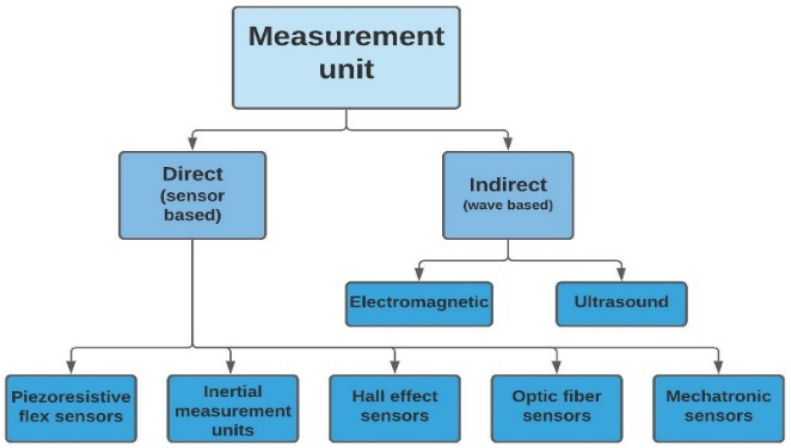
Figure 1. Classification of hand movement measuring devices according to their principle of opera- tion.